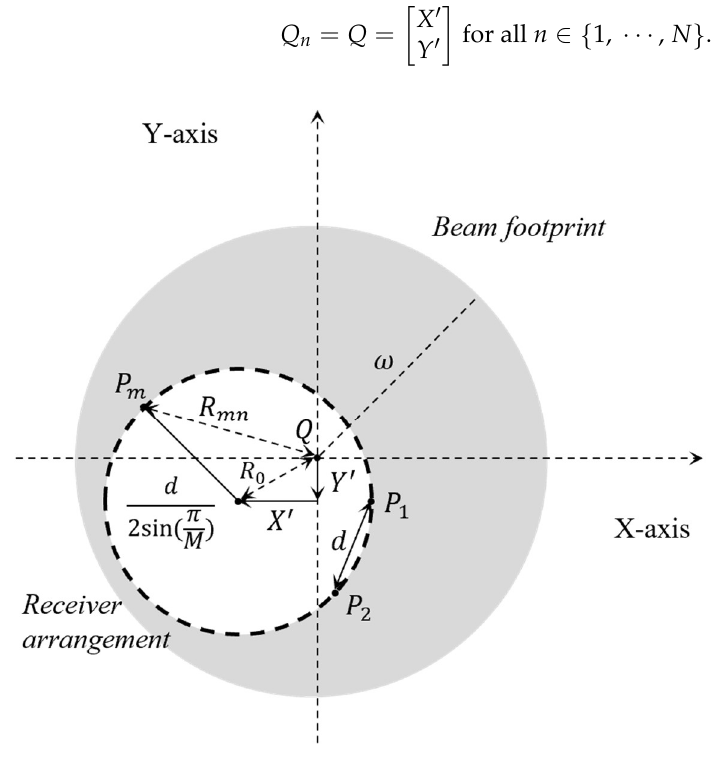
Figure 1. Beam footprint of the transmitter and receiver arrangement with pointing error. ′ ′ X and Y are the displacements due to the pointing error. Thus, the combined chan‑ nel gain for multiple transceivers in Equation (8) can be approximated with the random variables G, T , as referred to by [10] for MIMO